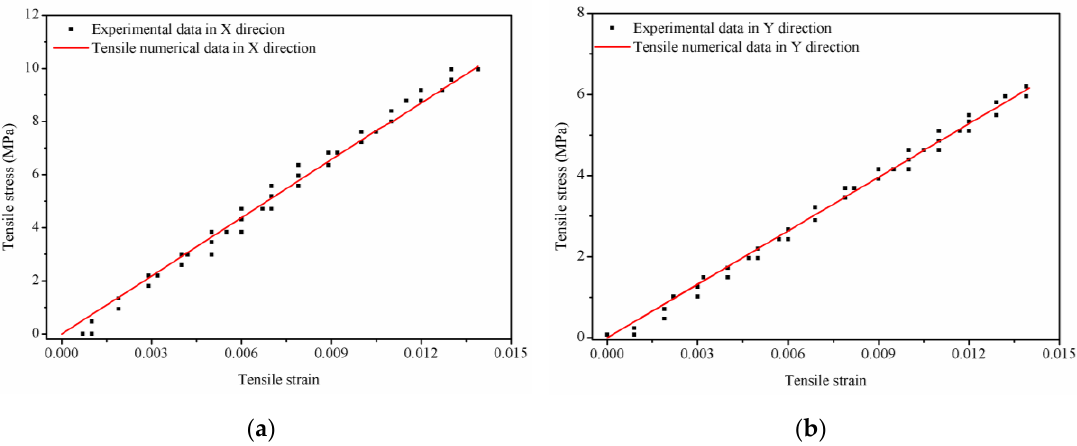
Figure 4. Tensile properties of a GDL with experimental and numerical results in the X and Y directions in ( a , b ).